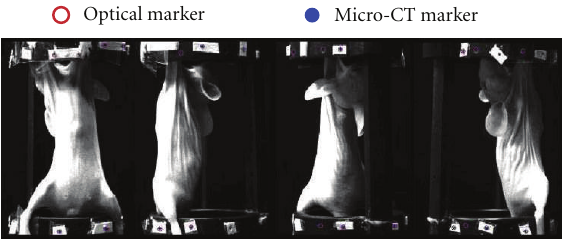
Figure 3: The views of the mouse bed with the fixed markers. The healthy mouse was injected with Fenestra LC and FDG. The rotation stage is set to rotate at 0 ◦ , 90 ◦ , 180 ◦ , and 270 ◦ for taking photos respectively. The CCD camera was fixed in front of the mouse